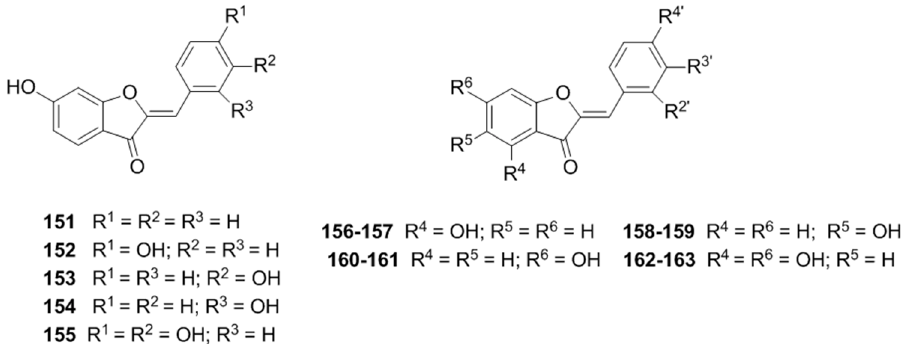
Figure 30. Structure of the synthetic aurones.